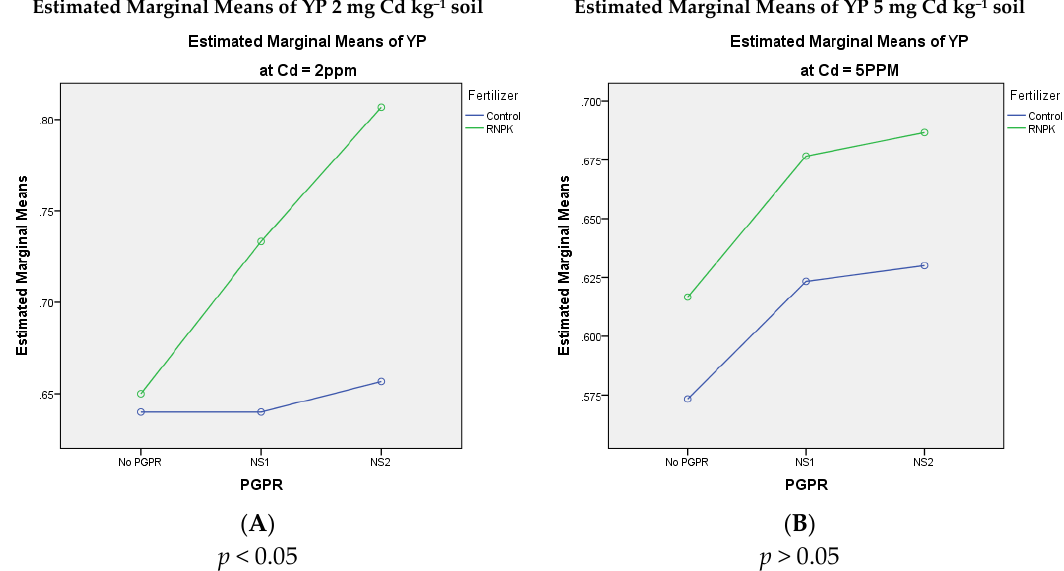
Figure 7. Interaction graph of S. maltophilia (NS1), A. fabrum (NS2), and RNPKF at 2 ( A ) and 5 mg Cd kg − 1 soil ( B ) for bitter gourd yield per plant (YP).